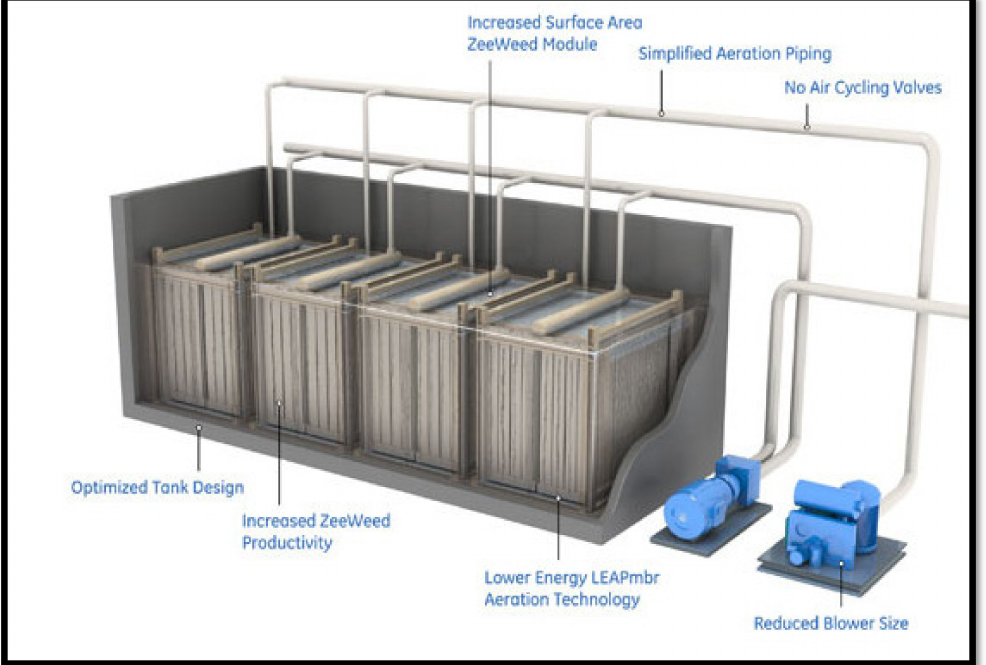
Figure 9. Membrane bioreactors for wastewater treatment